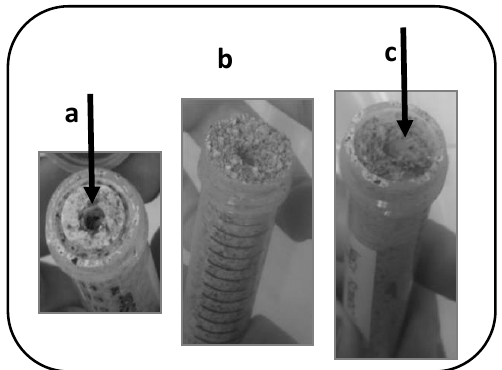
Figure 3. Experimental high moisture sorghum grain mini-silos opened after 7 days of incubation at 25°C. ( a ) Control (sterile water); ( b ) T1 (water kefir consortium); ( c ) T2 (filter-sterilized water kefir). Arrows indicate A. flavus growth.